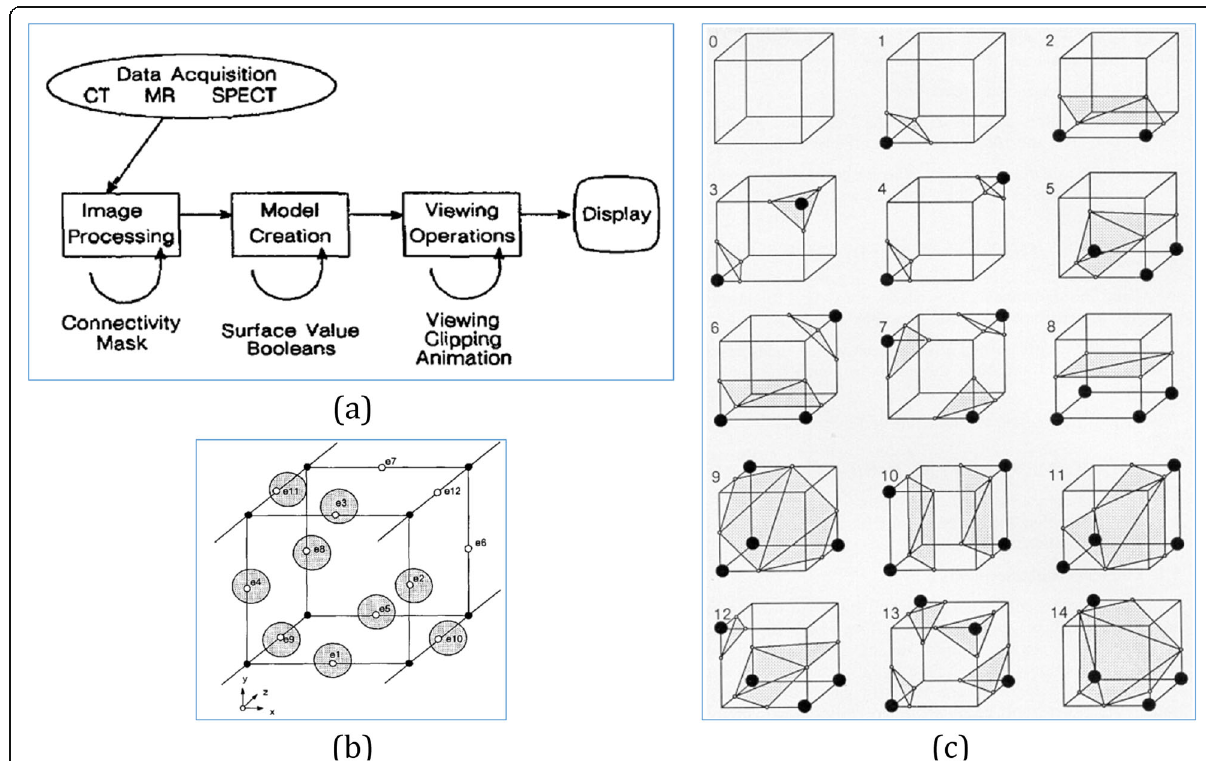
Fig. 1 The 3D medical information flow ( a ), interpolation process ( b ) and defined templates ( c ) in Marching Cubes techniques